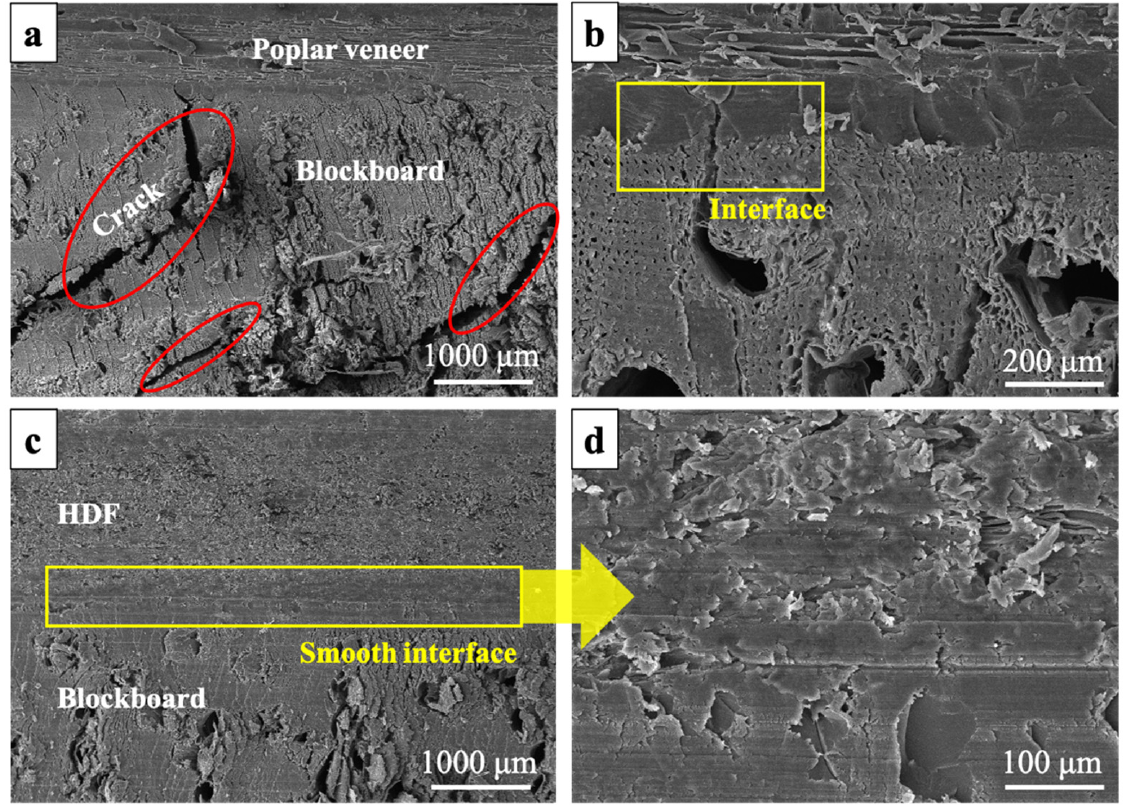
Figure 3. Interface morphology of the ecological board after dry heat treatment: ( a ) interface of poplar veneer/blockboard (100×); ( b ) interface of poplar veneer/blockboard (500×); ( c ) interface of HDF/blockboard (50×); and ( d ) interface of HDF/blockboard (500×).